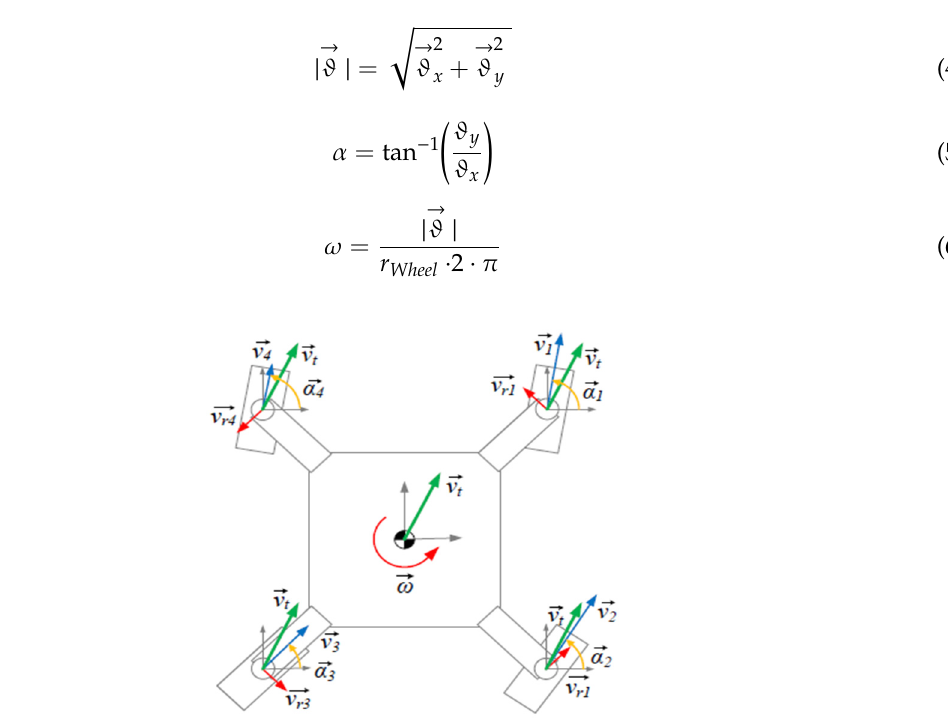
Figure 20. Motion vectors.